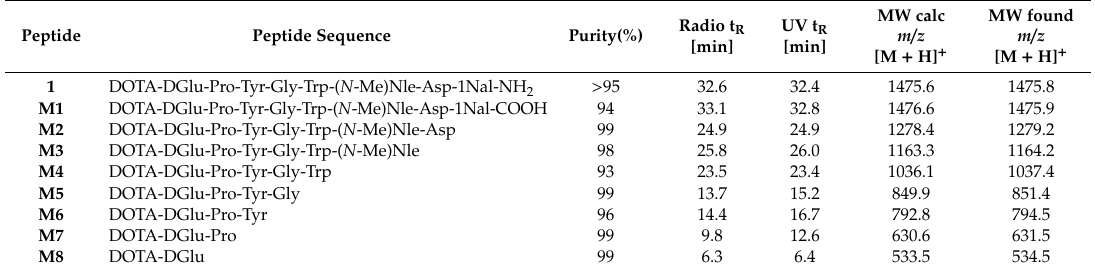
Table 1. Summary of the analytical data of 1 and the metabolites M1 – M8 (radio t R obtained after labeling with lutetium-177).